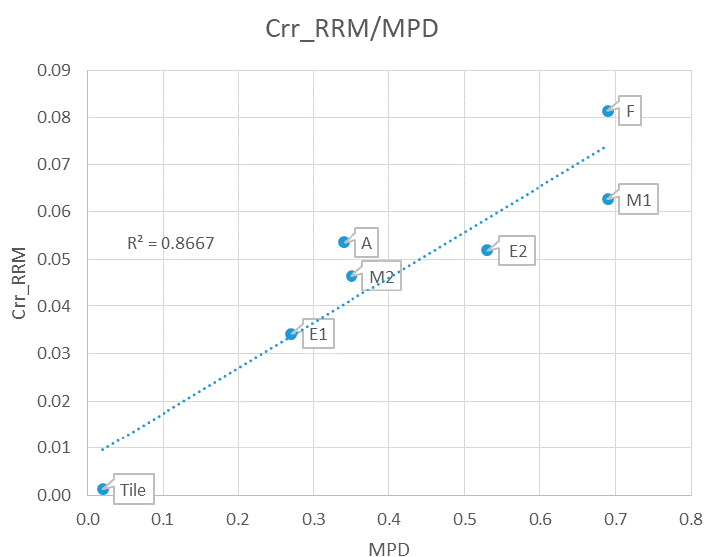
Figure 6. Correlation line between the MPD and Crr_RMM.